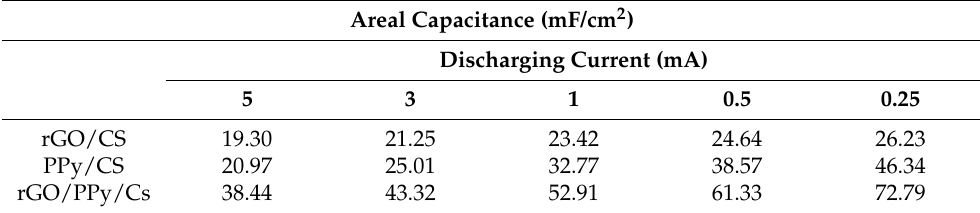
Figure 7. GCD curves of the SCs with ( a ) rGO/CS, ( b ) PPy/CS, and ( c ) rGO/PPy/CS nanocomposites under different discharge currents. Table 3. Areal capacitance of SCs analyzed from GCD